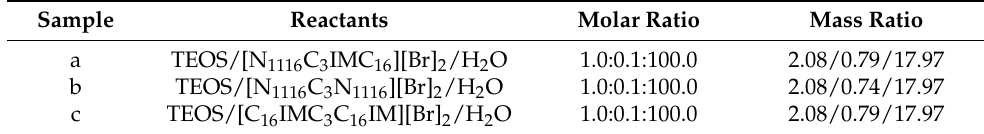
Table 1. Conditions used in the preparation of MCM-41.